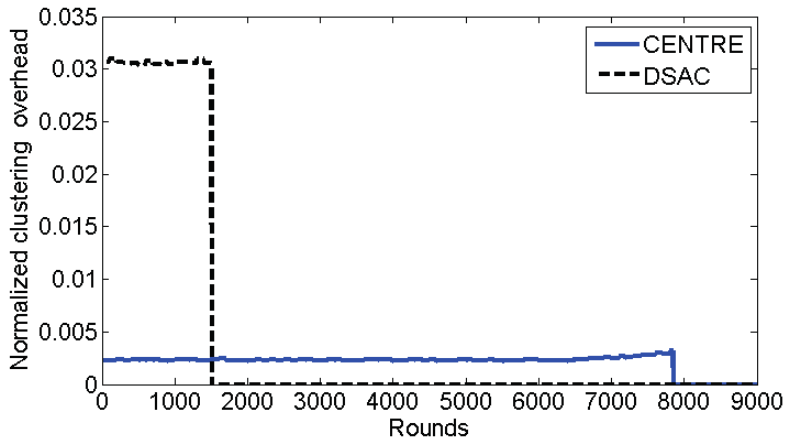
Figure 12. Normalized clustering overhead per round (showed until the lifetime of the two